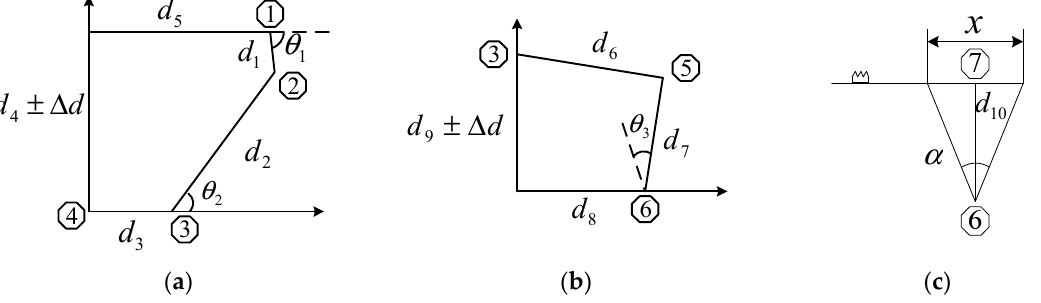
Figure 6. Constraint relationship diagrams of the feed mechanism. ( a ) Constraint relationship diagram 1. ( b ) Constraint relationship diagram 2. ( c ) Constraint relationship diagram 3.